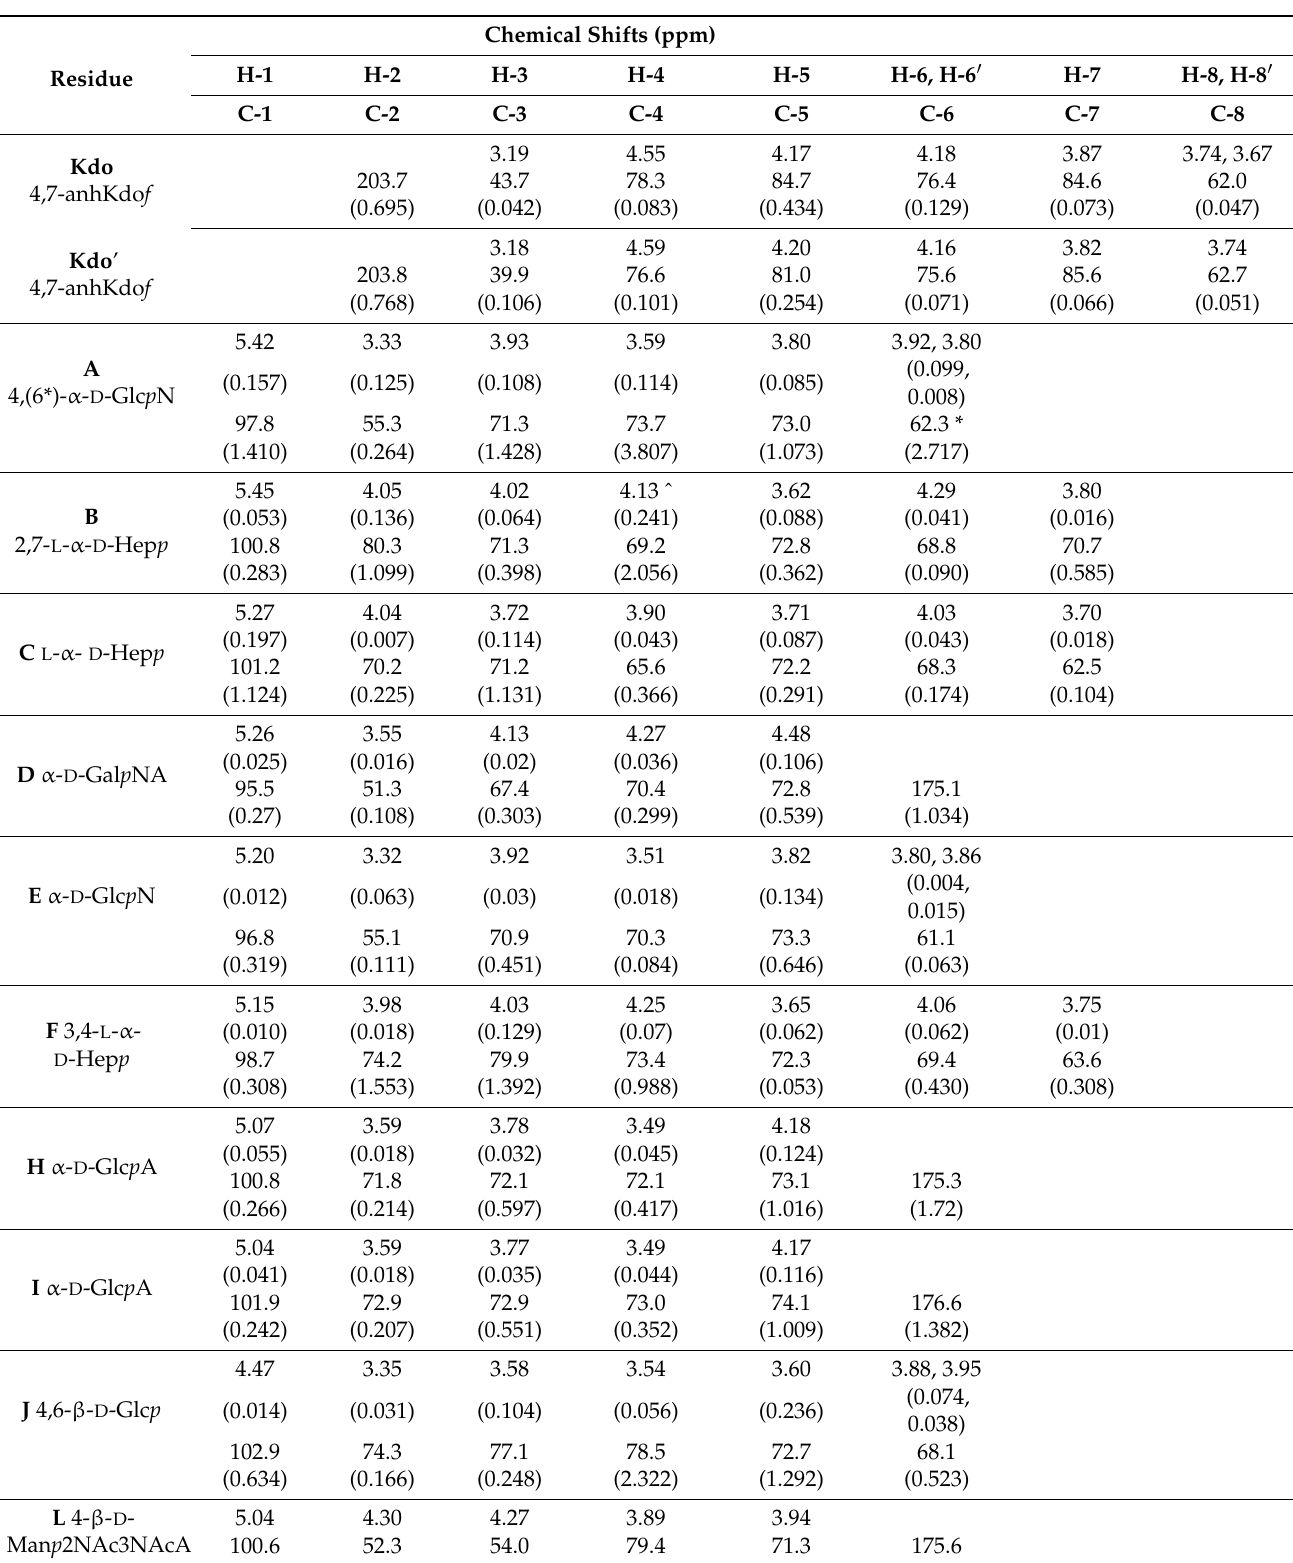
Table 1. 1 H, 13 C chemical shifts of monosaccharide OS components analyzed in Bordetellae in the same environment # .